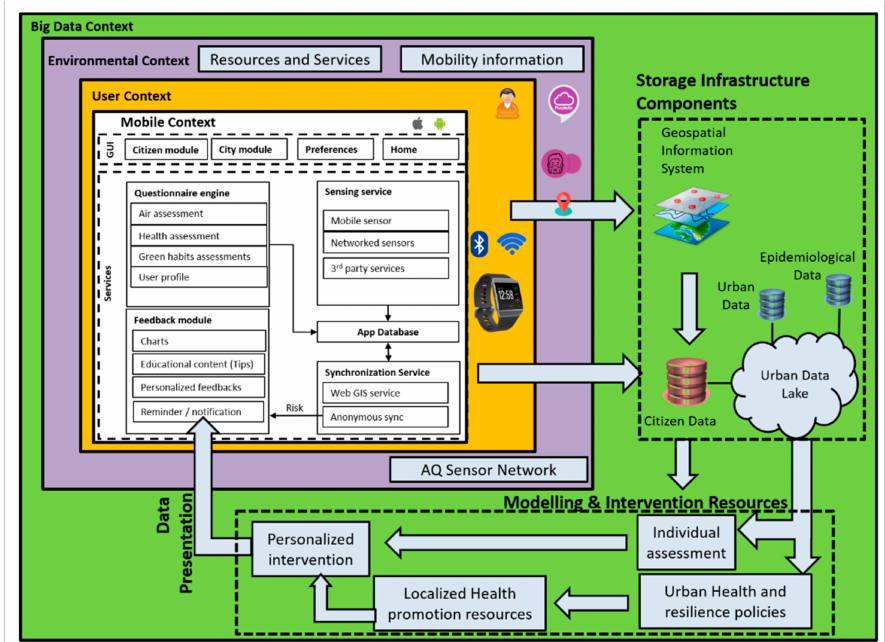
Figure 5. Big data-oriented ecosystem. GUI—graphical user